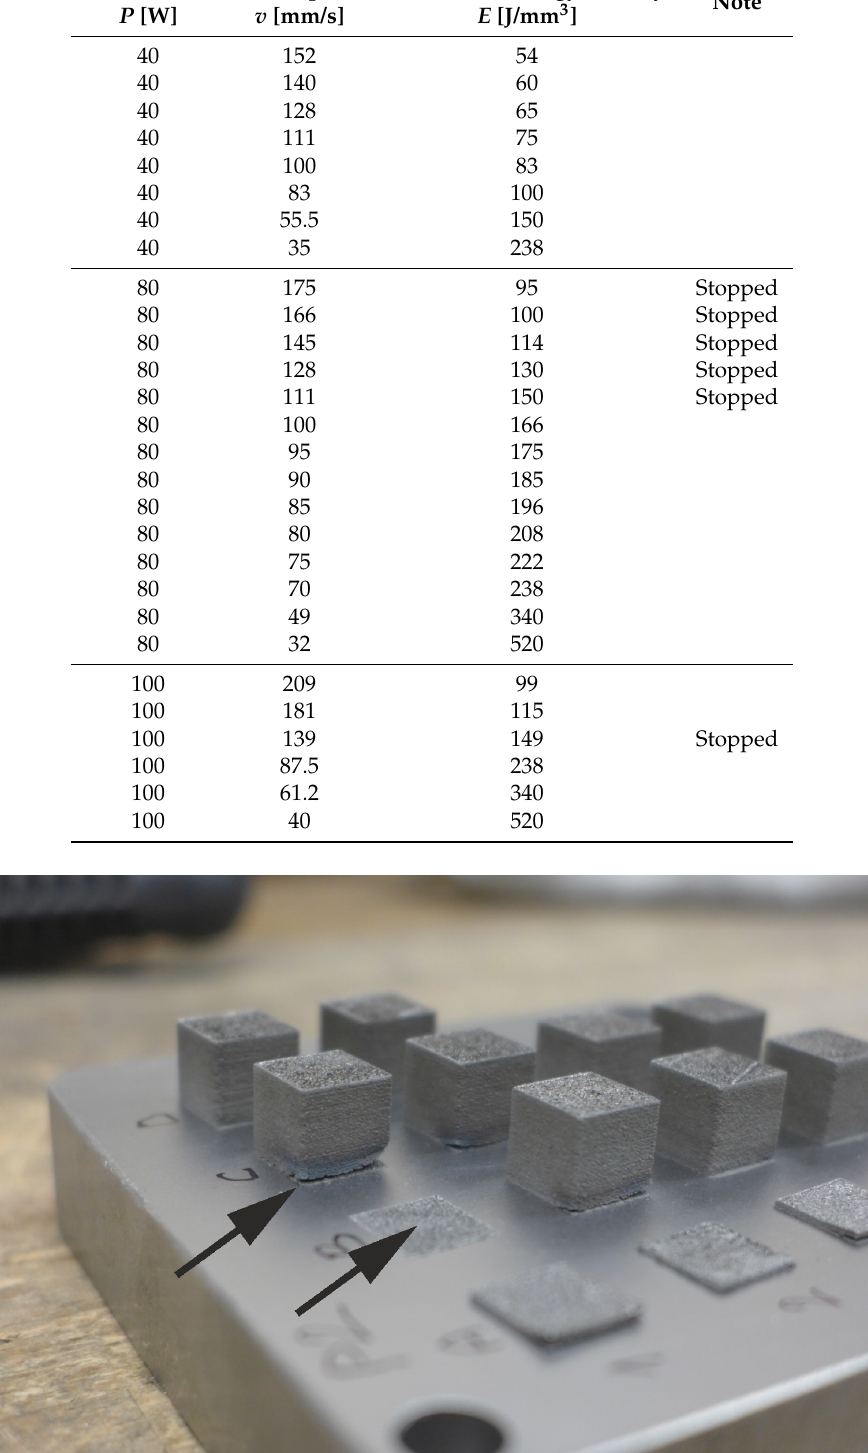
Figure 7. Poor adhesion of the initial layers of